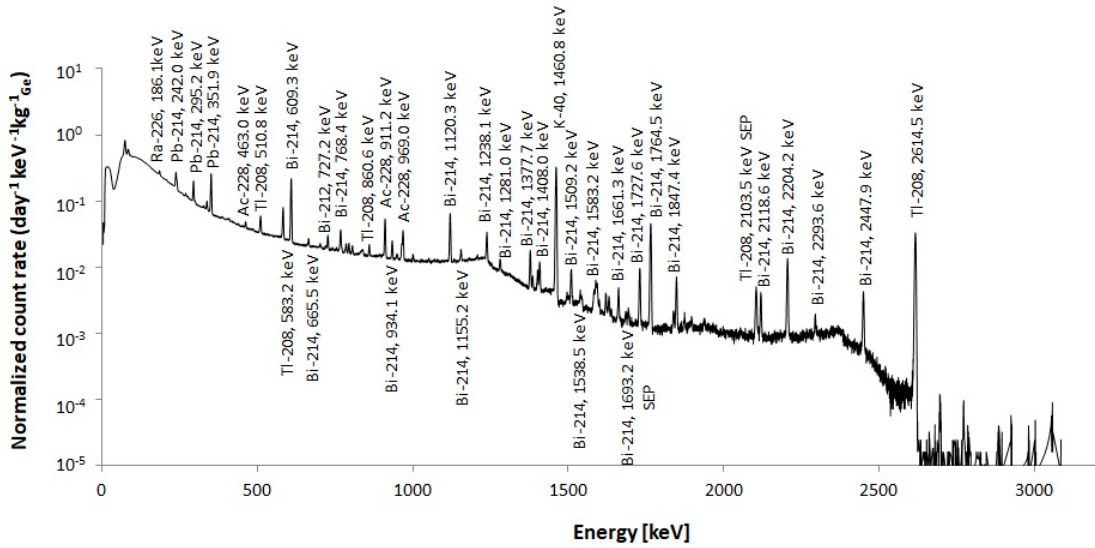
Figure 5. Gamma-ray spectrum registered at shaft L-VI and normalized to the day, photon energy, and germanium crystal mass. The main visible peaks are identified. Many low-energy lines between 20 and 150 keV were recognized, but for clarity of this presentation, they are not marked